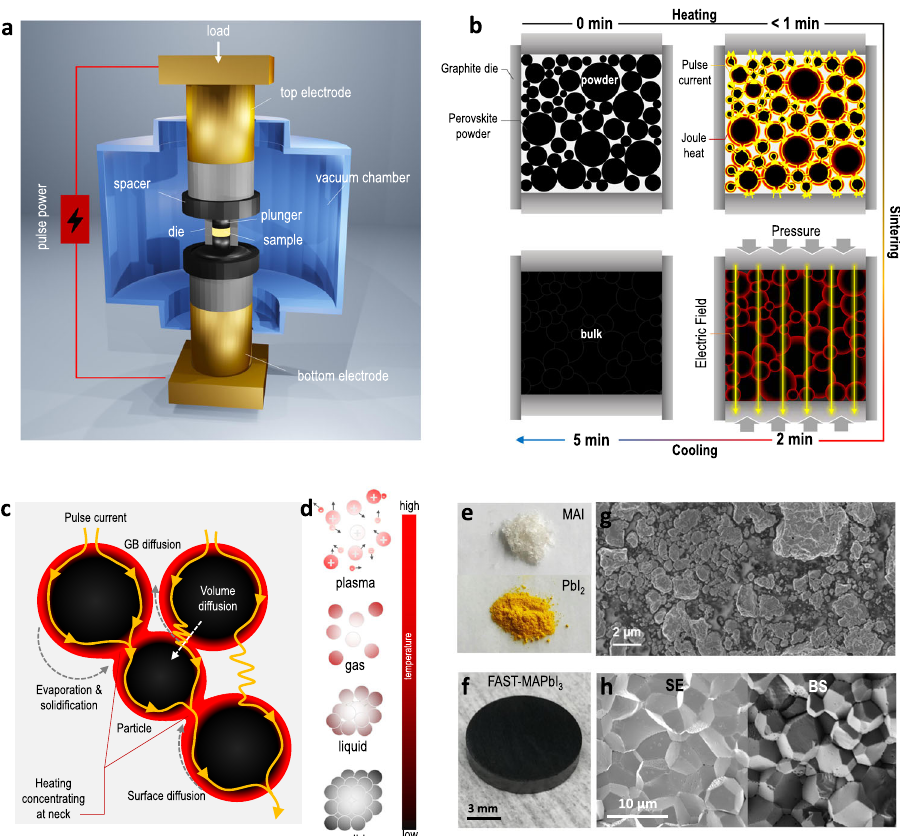
Fig.1|PrototypeFASTsynthesisofMAPbI 3 perovskite.a Setupcon fi gurationof FAST. In the chamber, a die with a loaded powder sample is sandwiched between the top and bottom electrodes, where the mechanical and electrical fi elds are applied. b Processingdiagramshowingthesoliddensi fi cationofhalideperovskites in the graphite die. c Mass transport mechanisms involved in the sintering, including volume diffusion, evaporation and solidi fi cation, grain boundary (GB) diffusion, and surface diffusion. The red color surrounding the sphere surface indicateslocalizedhighertemperaturesattheparticlesurface,whichcouldactivate